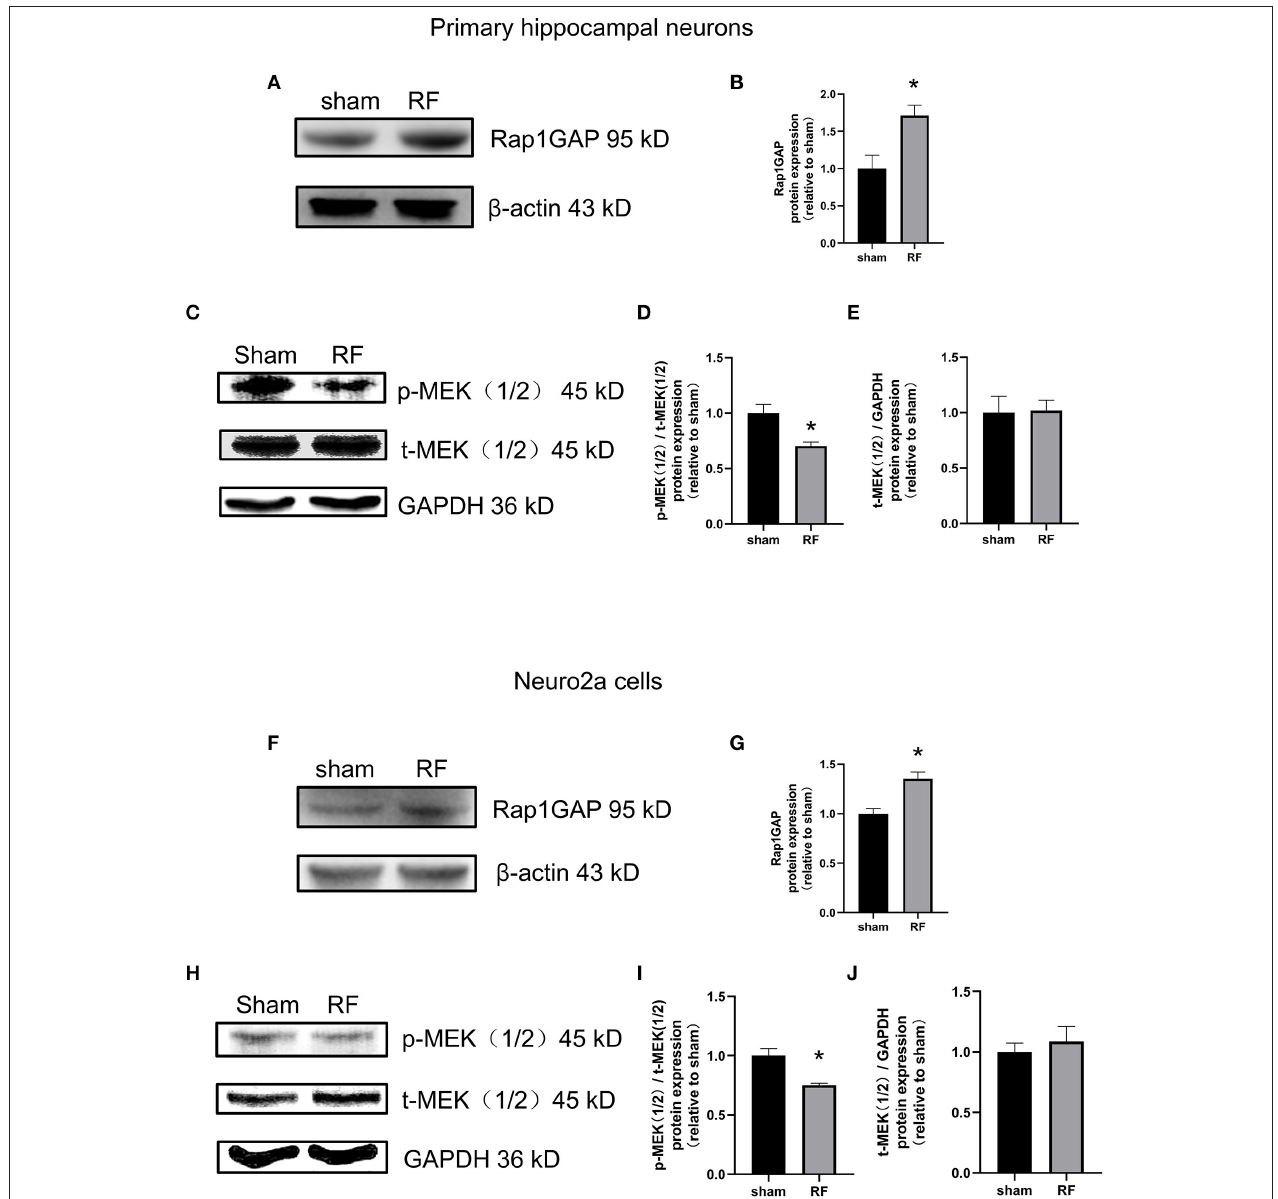
FIGURE 6 | Effects of RF-EMR exposure on the protein expression of Rap1GAP and p-MEK1/2 in neuronal cells. Neuronal cells were exposed to 4 W/kg RF-EMR for 48h. The protein expression of Rap1GAP in primary hippocampal neurons (A–E) and Neuro2a cells (F–J) were detected by western blot. (A,B) shows protein expression of Rap1GAP in primary hippocampal neurons, and (F,G) in Neuro2a cells. The expression levels of MEK1/2 and p-MEK1/2 after RF-EMR exposure for 48h were detected by western blot analysis in primary hippocampal neurons (C–E) and Neuro2a cells (H–J) . * P < 0.05, Student’s t